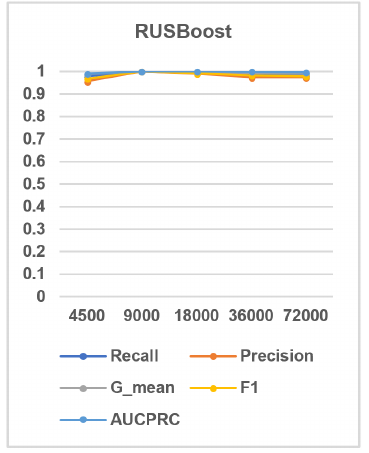
Figure 23. RUSBoost: Impact of Dataset Size